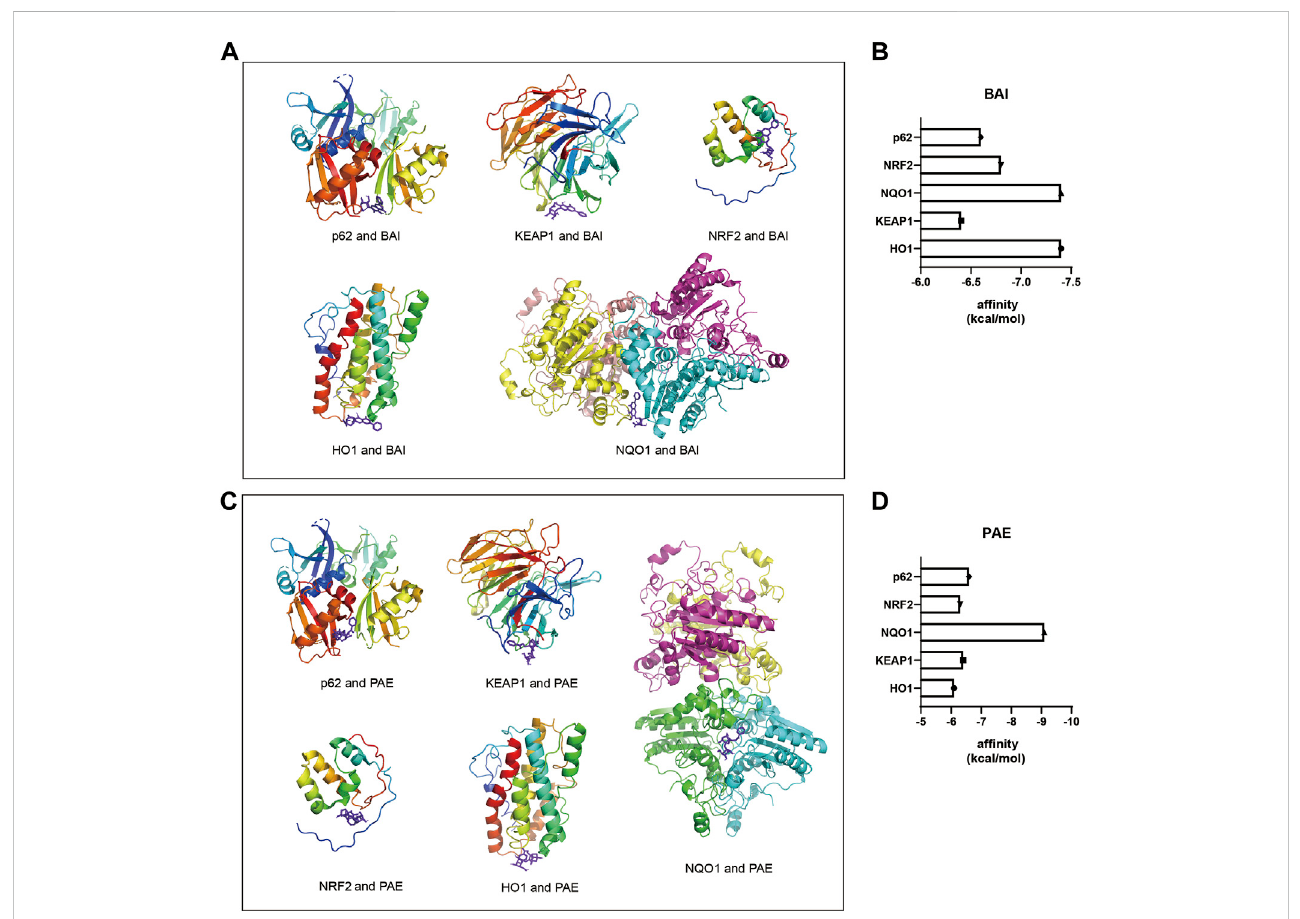
FIGURE 4 MoleculardockingdiagramsofBAIandPAEwithp62,KEAP1,NRF2,HO1,andNQO1. (A) MoleculardockingdiagramsofBAIwithp62,KEAP1,NRF2,HO1, and NQO1 proteins. (B) Binding af fi nity (kcal/mol) of BAI with p62, KEAP1, NRF2, HO1, and NQO1 proteins. (C) Molecular docking diagrams of PAE with p62, KEAP1,NRF2,HO1,andNQO1proteins. (D) Bindingaf fi nity(kcal/mol)ofPAEwithp62,KEAP1,NRF2,HO1,andNQO1proteins.BAI,Baicalin;PAE,Paeoni fl